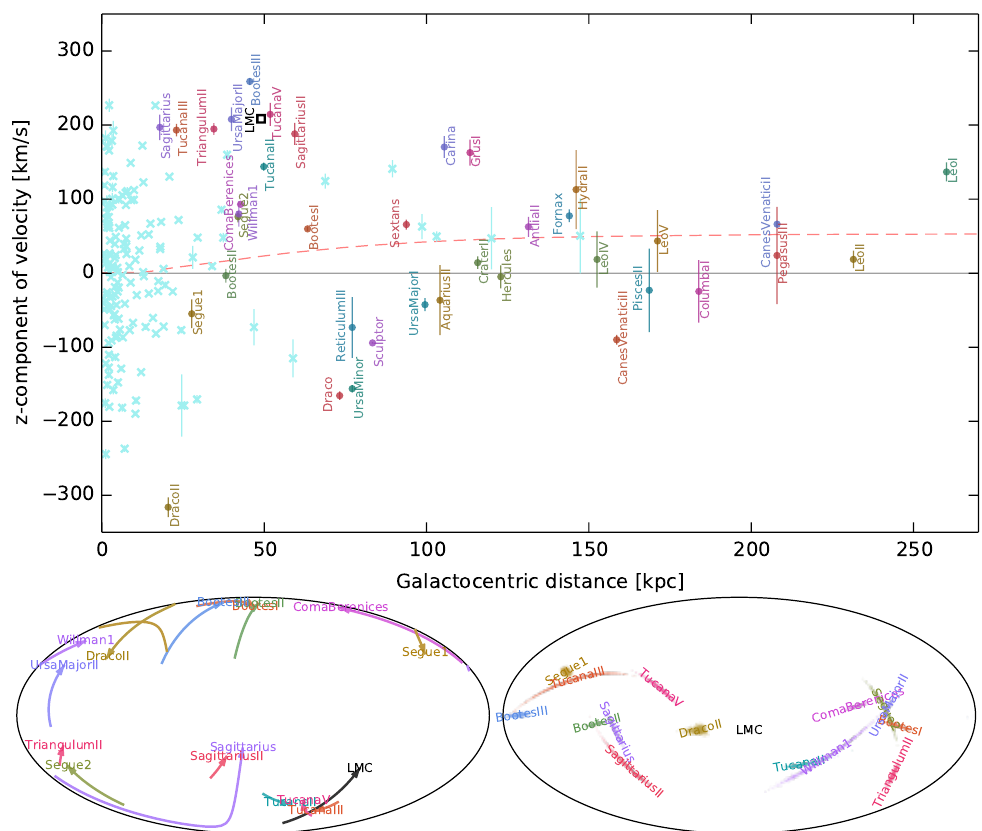
Figure 6. Top panel: z -component of Galactocentric velocity for Milky Way globular clusters (cyan crosses) and satellite galaxies (coloured circles; the colour only serves to distinguish them more easily) plotted against Galactocentric distance. The LMC is shown by a black square, and its satellites are excluded from the plot; nevertheless, there is a conspicuous concentration of a dozen unrelated galaxies with positive v z within 70 kpc. Further out, the bias towards positive v z is less prominent, but still noticeable. The red dashed line shows the mean v z in the present-day snapshot of the fiducial N -body simulation shown in Figure 5. It does not explain the coherent group of galaxies with v z 200 km s − 1 in the inner region, but qualitatively matches the positive bias in the outer (cid:39) region. Bottom left panel: orbits of selected satellites with current Galactocentric distances under 70 kpc, computed for the last 100 Myr and shown in Mollweide projection as viewed from the Galactic centre. Although many of them have similar values of v z 200 km s − 1 , they are not located in the (cid:39) same region of space (except the three Tucana and three Boötes galaxies), nor share common orbits. Bottom right panel: directions of orbital poles for the same selection of orbits (similar to the top panel of Figure 3 in [113] or the left panel of Figure 9 in [37]). Again, there is no significant non-uniformity in this distribution, suggesting that the velocity values are purely